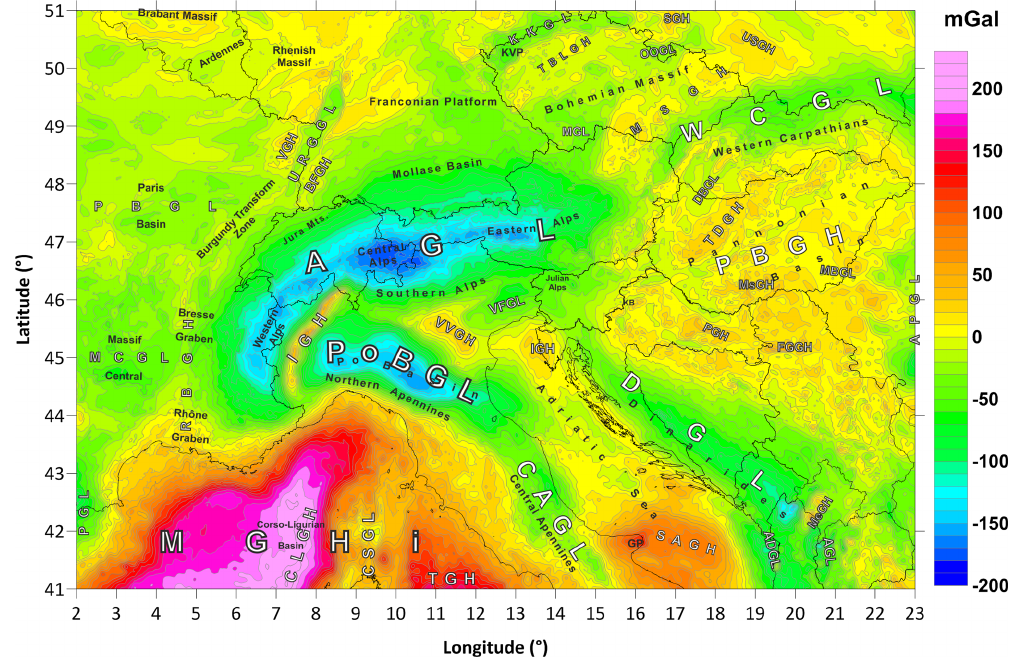
Figure 13. New pan-Alpine Bouguer gravity anomaly map. The first order dominant regional gravity anomalies: AGL – Alpine gravity low, PoBGL – Po Basin gravity low, CAGL – the Central Apennine gravity low, IGH – Ivrea gravity high, VVGH – Verona/Vicenza gravity high, VFGL – Venetian/Friuli Plain gravity low. The second dominant regional gravity anomaly: MGHi – Mediterranean gravity high, CLGH – Corso/Ligurian gravity high, TGH – Tyrrhenian gravity high, CSGL – Corsica/Sardinia gravity low, SAGH – south Adriatic gravity high, IGH – Istria gravity high, WCGL – Western Carpathian gravity low, DGL – Dinaric gravity low, MeGH – Merdita gravity high, ADGL – pre-Adriatic depression, PBGH – Pannonian Basin gravity high, TDGH – Transdanubian gravity high, PGH – Papuk gravity high, MsGH – Mecsek gravity high, FGGH – Fruška Gora gravity high, DBGL – Danube Basin gravity low, MBGL – Makó/Békés Basin gravity low, APGL – Apuseni gravity low. The rest of the study area: PGL – Pyrenean gravity low, MCGL – Massif Central gravity low, PBGL – Paris Basin gravity low, URGGL – Upper Rhine graben gravity low, RBGH – Rhône/Bresse Graben gravity high, BFGH – Black Forest